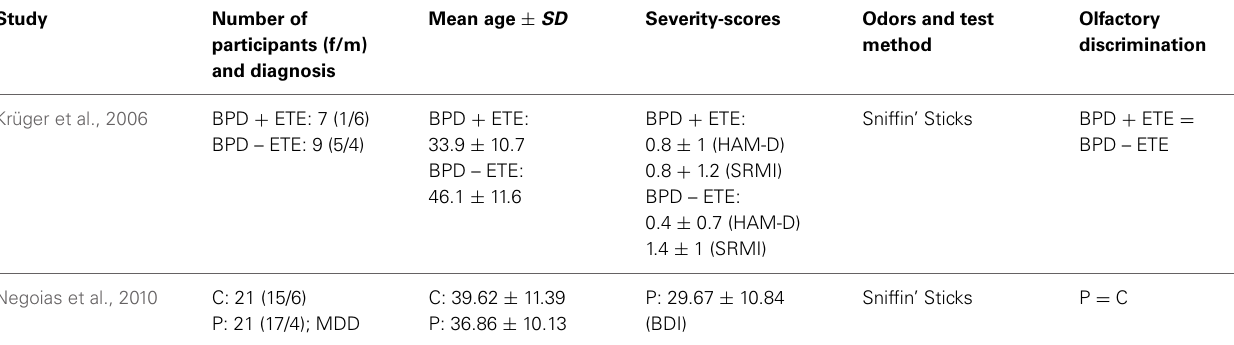
Table 3 | Summary of studies of olfactory discrimination in affective